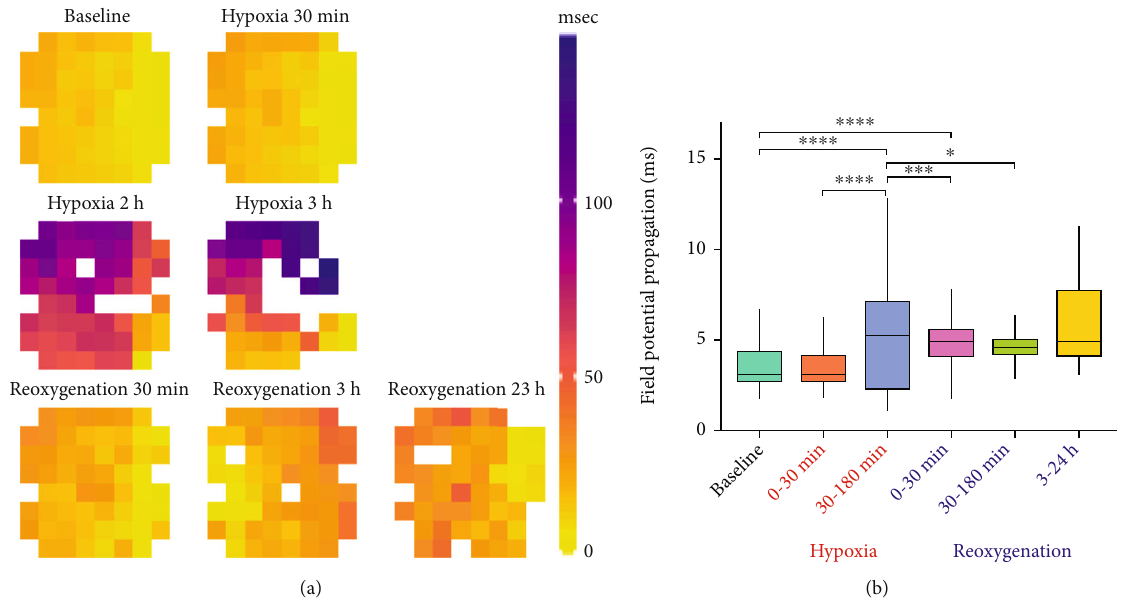
Figure 5: Field potential propagation (FPP) through the hiPSC-CM sheet during baseline, hypoxia, and reoxygenation. (a) Propagation of the FP the hiPSC-CM sheet on the MEA electrodes during baseline and di ff erent hypoxia and reoxygenation timepoints. (b) Hypoxia signi fi cantly increased the FPP time calculated between adjacent electrodes, whereas reoxygenation decreased it. However, even at the end of the reoxygenation period, the FPP remains increased compared to the baseline. ∗ p < 0 : 05 , ∗∗∗ p < 0 : 001 , and ∗∗∗∗ p < 0 : 0001